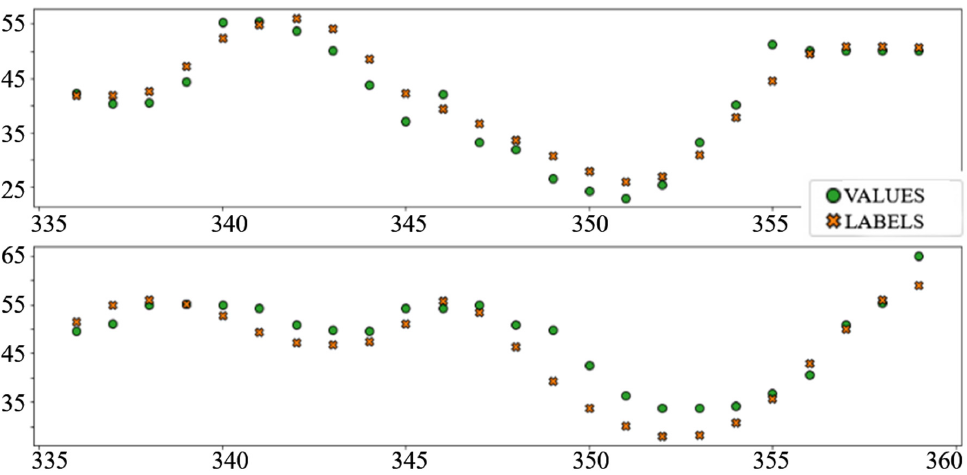
Figure 14. Price prediction examples: “Dense_LSTM_Dense”.